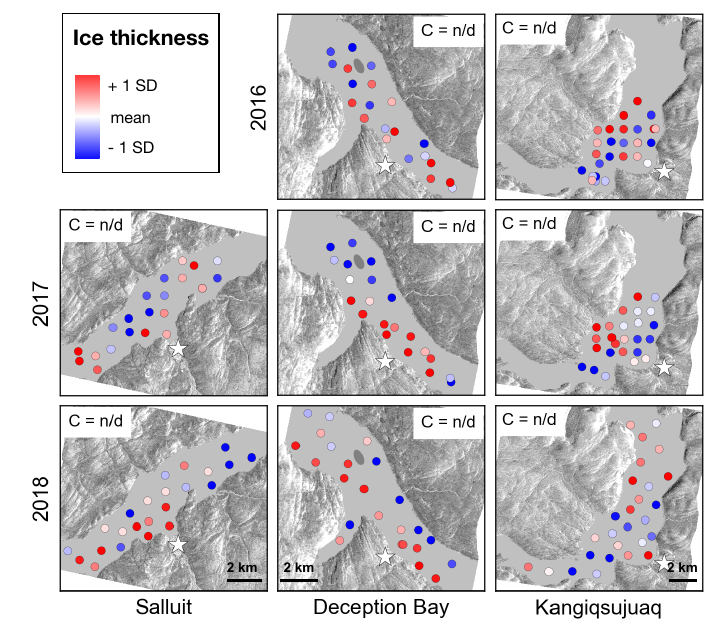
Figure 4. Same as Figure 3 but for ice